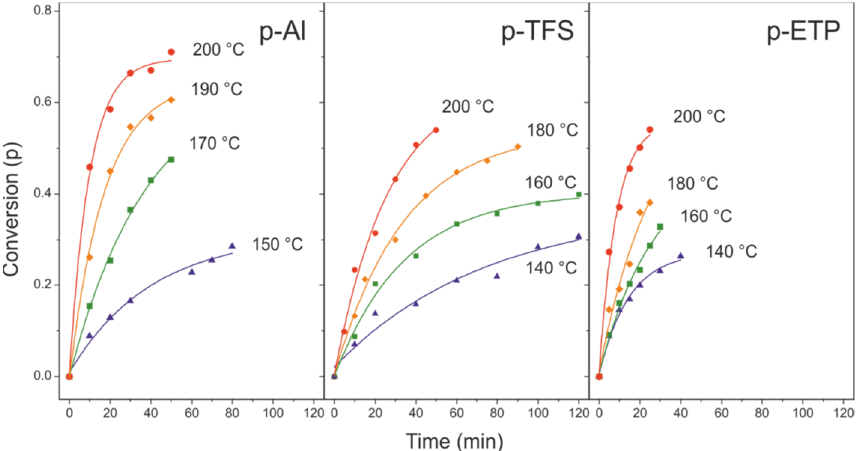
Figure 4. Esterification conversion within polyaleuritate films formed on Al, TFS and ETP supports as a function of temperature and reaction time.